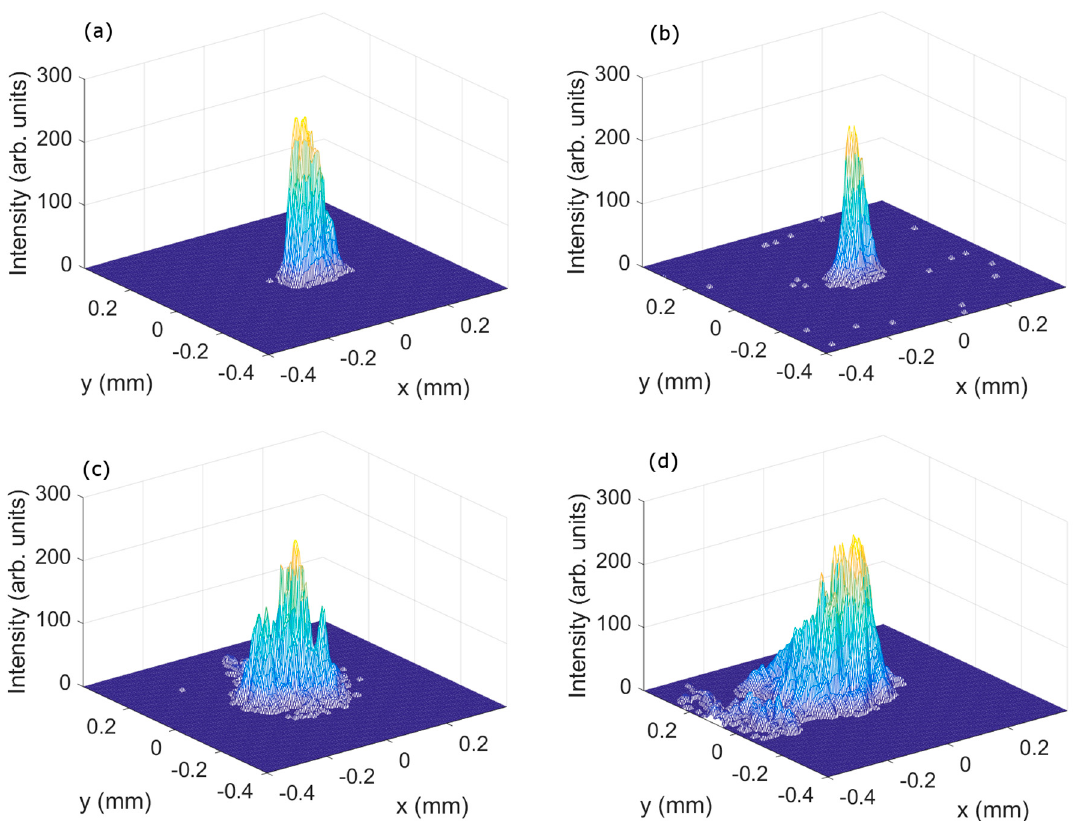
Figure 7. Intensity images of the HL lenses recorded ( a ) and ( b ) asymmetrically and ( c ) and ( d ) symmetrically, evaluating ( a ) and ( c ) at 473 nm and ( b ) and ( d ) at 633 nm. Polymers 2018 , 10, x FOR PEER REVIEW After evaluation, a sample with two HLs can be observed in Figure 8. The spots of the negative asymmetrical HLs diffracted the daylight in the normal direction of the sample plane. The unexposed zones were practically transparent to the sunlight.